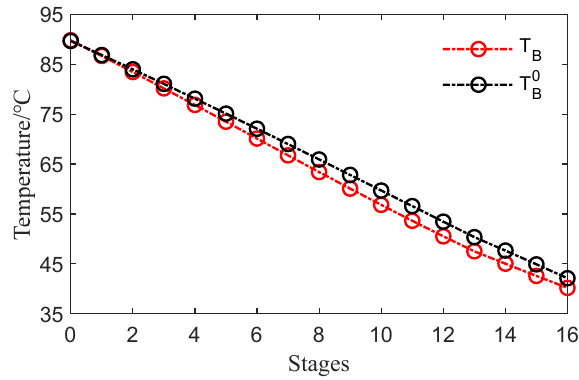
T distribution comparison. Figure 9. Figure 9. T Bj distribution Bj